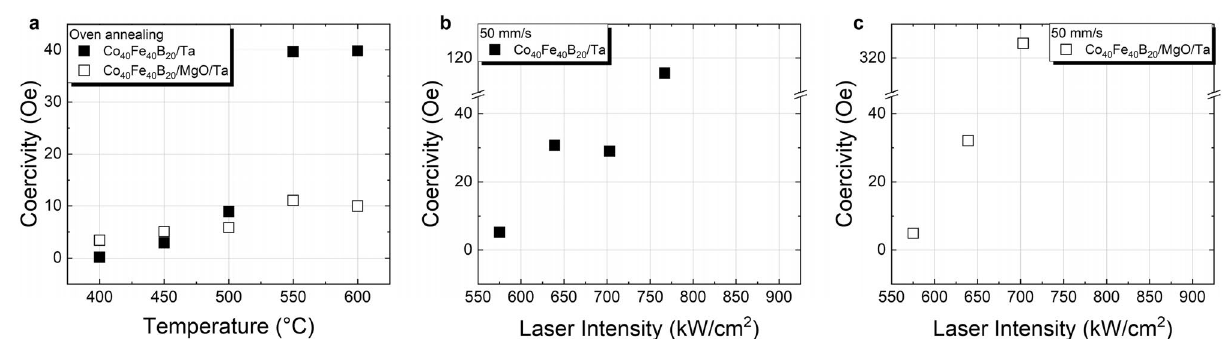
Figure 8. Coercive fields of Co 40 Fe 40 B 20 capped with Ta or MgO/Ta determined by SQUID magnetometry measuring M ( H ) hysteresis loops up to magnetic saturation at room temperature for ( a ) samples annealed